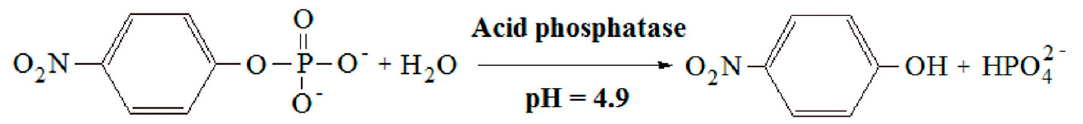
Figure 8. Scheme of the reaction catalyzed by acid phosphatase. The reaction rate was determined by the rate of loss of the amount of substrate (p-nitrophenyl phosphate) and the increase in the amount of product (p-nitrophenol) per unit of time.